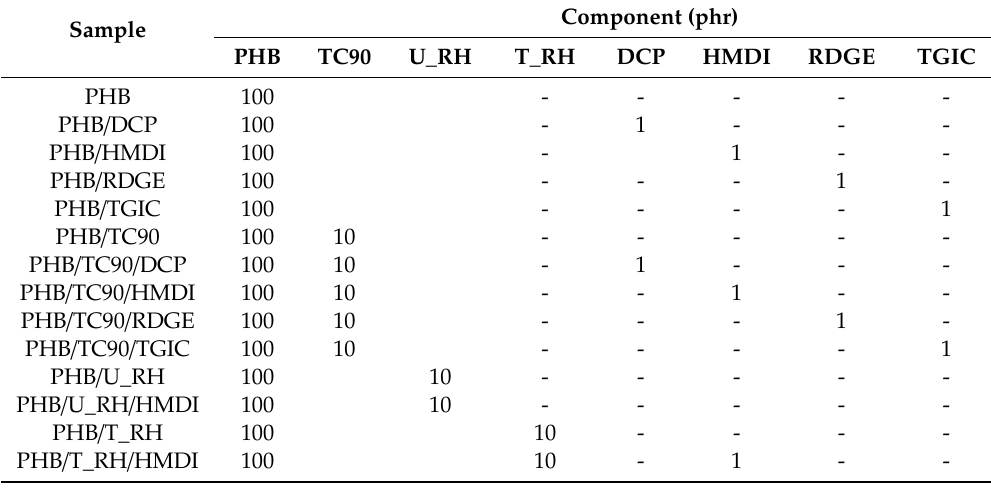
Table 1. Summary of studied formulations. DCP: dicumyl peroxide, HMDI: